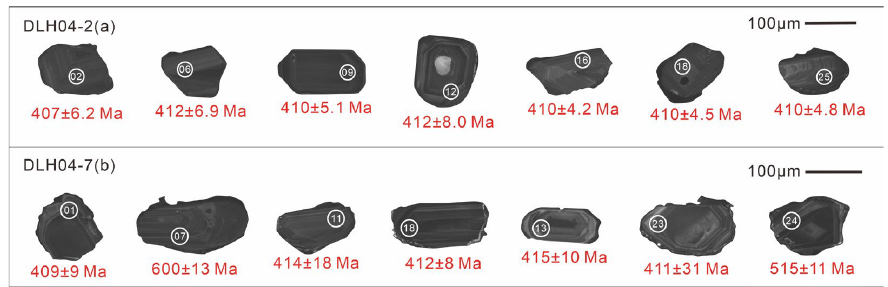
Figure 5. Cathodoluminescence (CL) images and zircon U - Pb ages from the felsic volcanic rocks of the Maoniushan Formation.